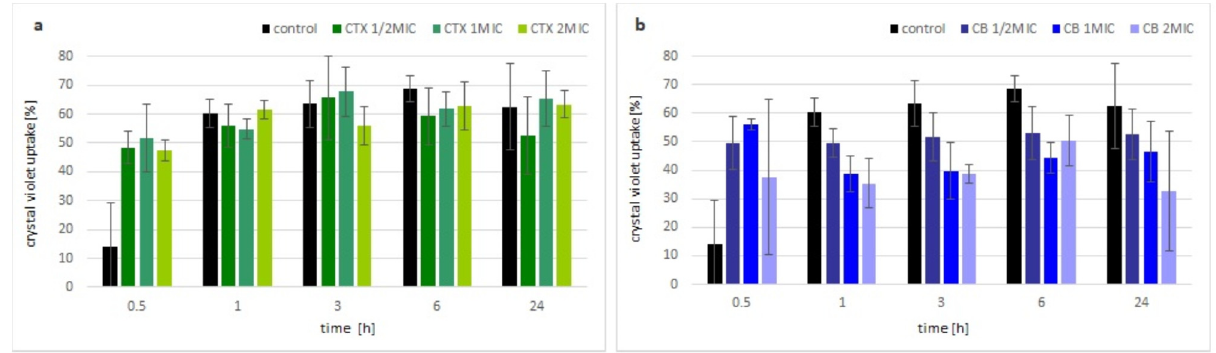
Figure 2. Membrane permeability of toxin incubated M. luteus. Time-dependent percentage of crys- tal violet uptake of treated cells with various concentrations of: ( a ) crotoxin, ( b ) CB subunit, in different time points. Error bars represent the standard deviation of three replicates.